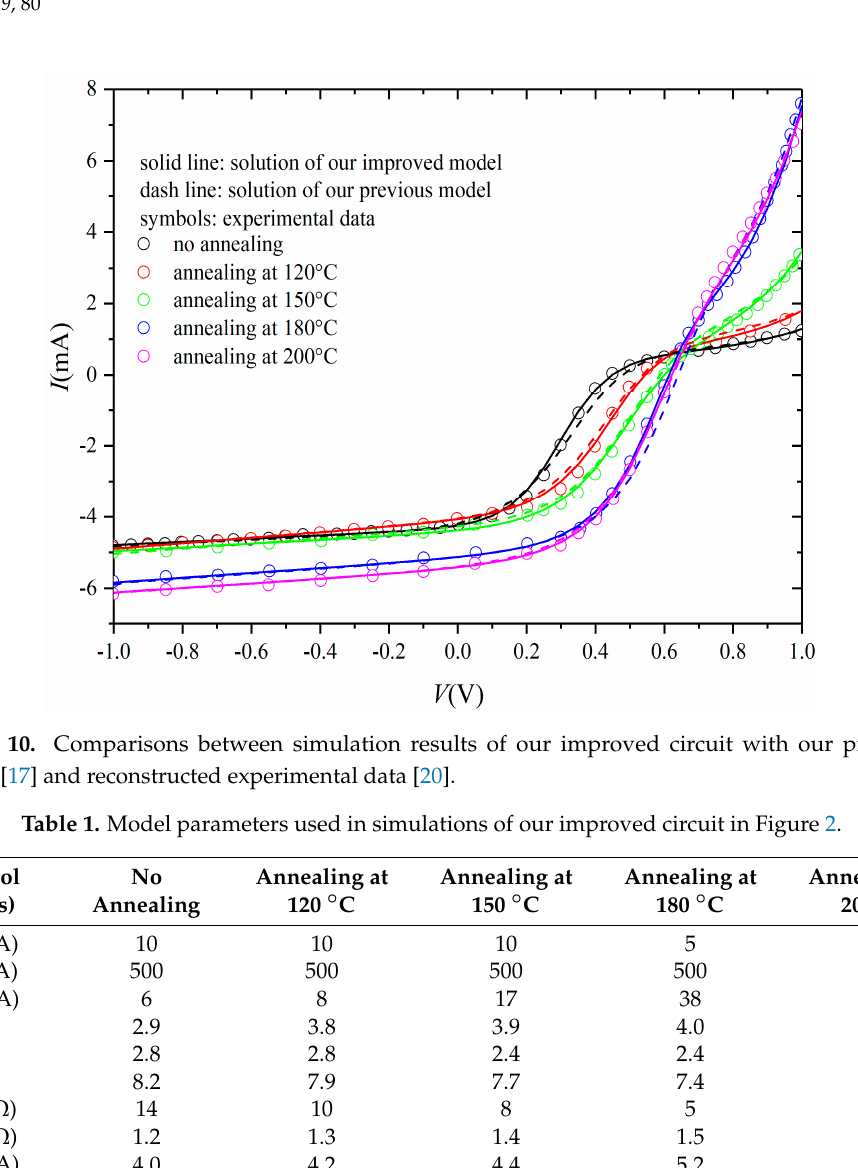
8 of 10 Table 1. Model parameters used in simulations of our improved circuit in Figure 2. Symbol (Units) 5.5 Table 2. Model parameters used in simulations of our previous model [17] in Figure 1. Symbol (Units)